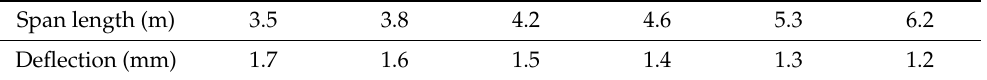
Table A1. 1 kN deflection limit of lightweight cold-formed steel composite floors based on SCI P354. Span length (m)